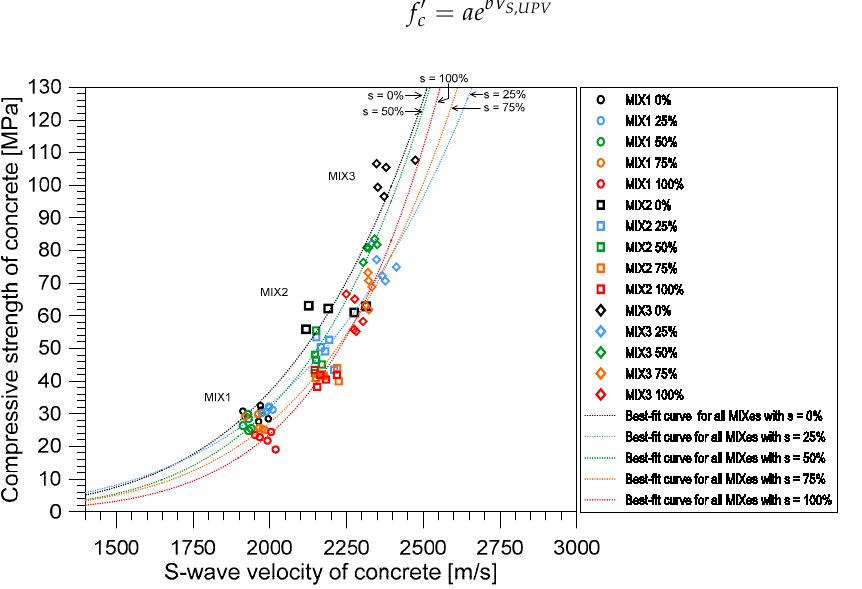
Figure 17. Relationship between shear wave velocity and the compressive strength of saturated concrete.